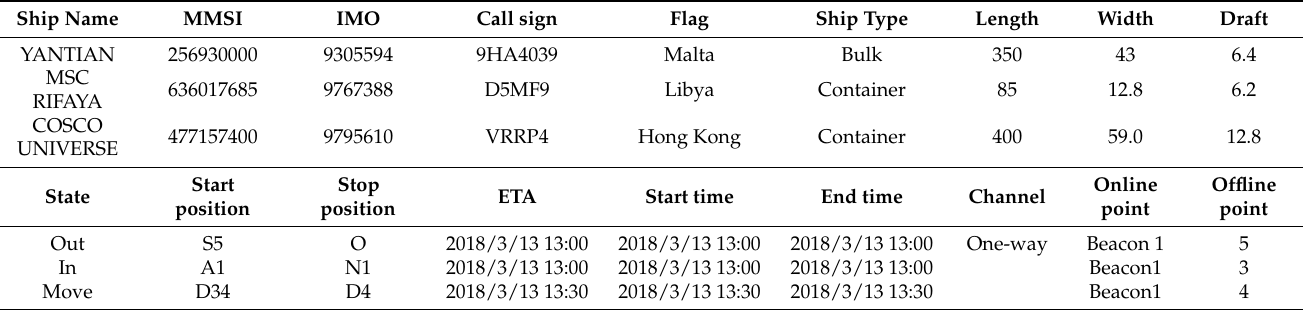
Table 2. Sample vessel plan.